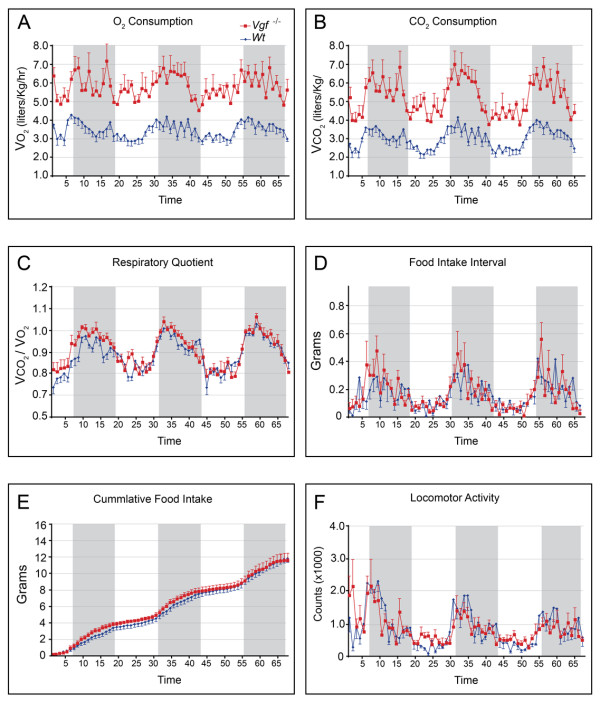
VGF-deficient mice on a C57Bl6 background are hypermetabolic, with normal food intake and locomotor activity. Metabolic cage analysis revealed that VgfR -/- mice have significantly increased O2 (V02, panel A) and CO2 (VCO2, panel B) consumption (two-tailed t-test; p ≤ 0.05), while respiratory quotient (panel C), food intake (panels D and E) and locomotor activity (panel F) were similar to wild type littermates (n = 7-8 mice of each genotype). Alternating white and grey shaded regions in panels E-F represent light rest and dark active periods, respectively.